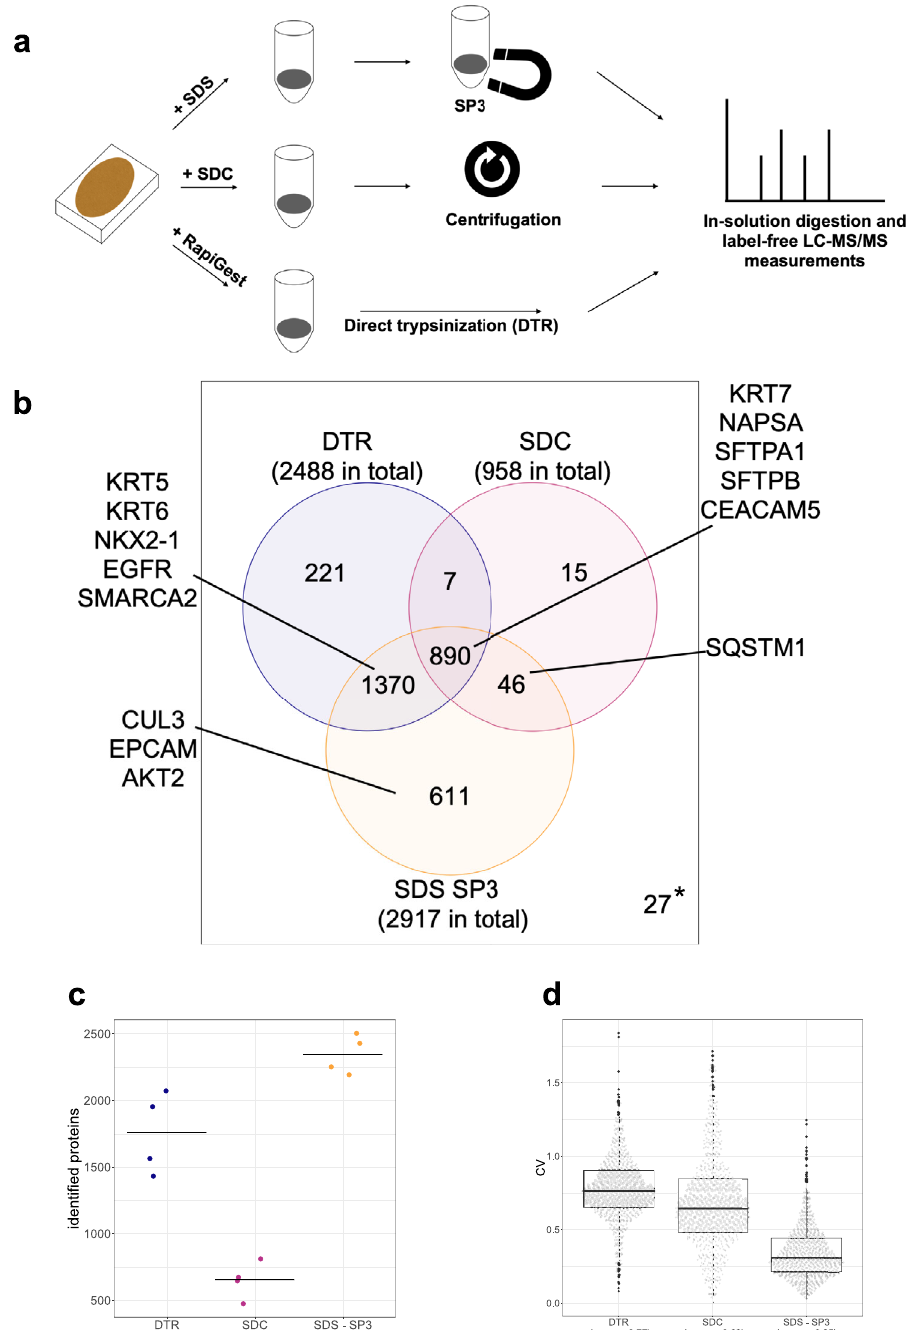
Fig. 1 SDS-SP3 protocol performs best in terms of total identi fi ed proteins and identi fi ed NSCLC disease-related proteins. a Comparison of three sample preparation protocols for FFPE proteome analysis. Deparaf fi nized FFPE lung tissues were lysed with different buffers containing either SDS, SDC, or RapiGest, and detergents were removed before digestion and LC-MS/MS analysis. b Overlap of proteins identi fi ed in DTR, SDC, and SDS-SP3 treated samples with NSCLC-relevant proteins highlighted as quality control. * marks proteins only identi fi ed but not quanti fi ed in any of the groups (27). c Proteins identi fi ed from a 1 µ g single-shot injection from the samples processed with the three protein extraction protocols, the black bar is showing the mean of the group. Source data are provided as a Source Data fi le. d Boxplots plots showing the distribution of coef fi cients of variation (CV) per protein across four replicates for each protocol with boxplots. The plot depicts the 25th and 75th quartile (box), the median (thick black line), the minimum and maximum (whiskers, Q1-1.5*IQR, Q3 + 1.5*IQR), and outliers (dots). Source data are provided as a Source Data fi